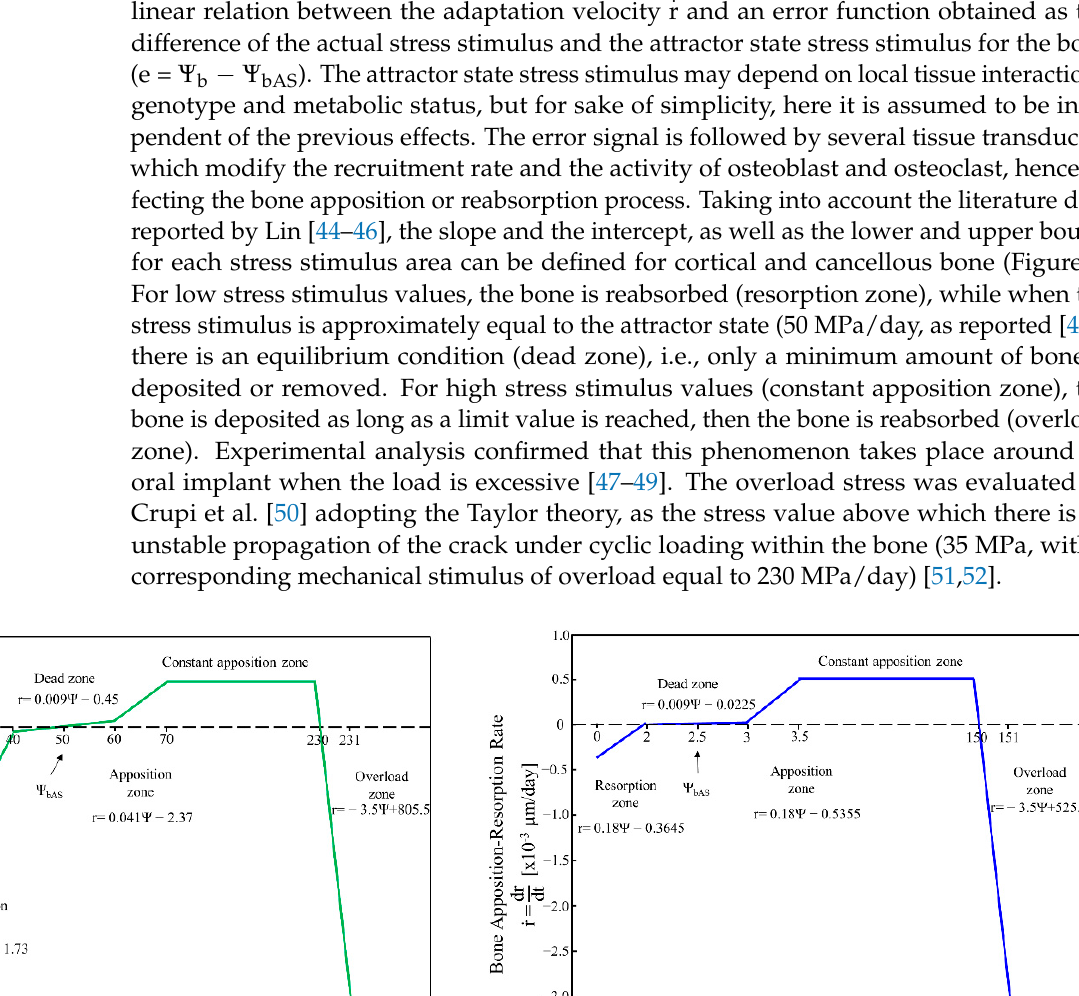
with 𝑟(cid:4662) being the bone apposition/resorption rate, ρ t the fully mineralized tissue density, k r the active bone surface constant (assumed equal to 0.2 [53]), and S v ( ρ ) the bone surface area density, defined as the amount of bone surface area in a given bone sample divided by the bulk volume (full and empty spaces). The relationship between the bone surface area density and porosity was experimentally retrieved by Martin [54], with porosity ex- pressed as a function of the bone apparent density (Equation (3)).